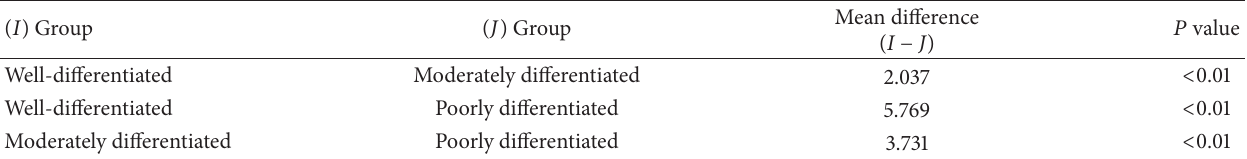
Table 4: Evaluation of the podoplanin expression between groups of OSCC (Tukey HSD test).